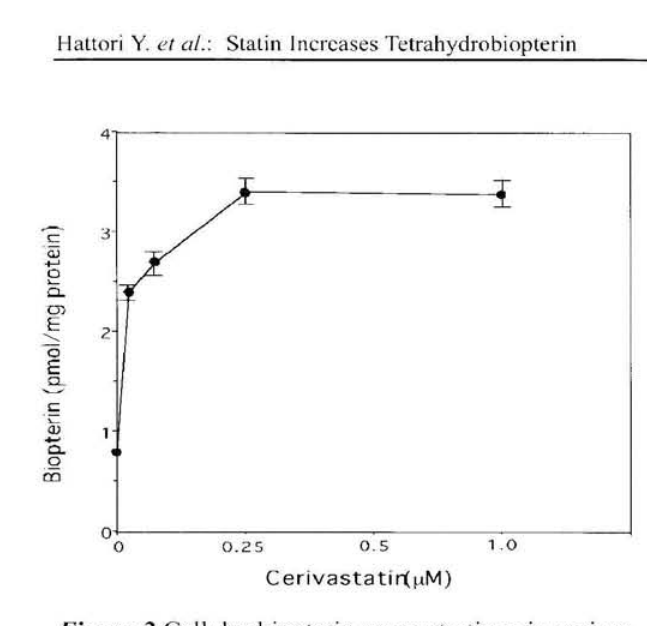
Figure 2 Cellular bioptcrin concentrations in cerivas- tatin-treated HUVEC. Cells were incubated with cerivastatin (O.Ol - I μΜ) for 24 h, after which cellu- lar biopterin (B1I4 and more oxidized spccics) was measured. Data represent the mean i SEM (n—3). **p <0.01 compared with control.